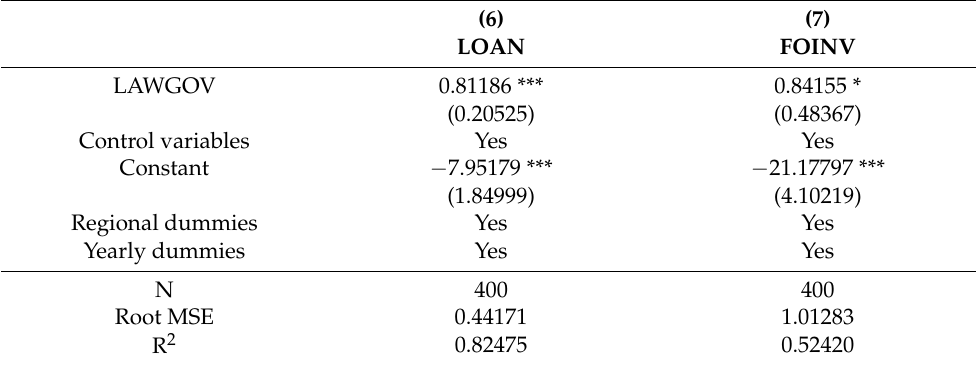
Table 5. Correlation between law-based governance and financial loans, and correlation between law-based governance and foreign investment.